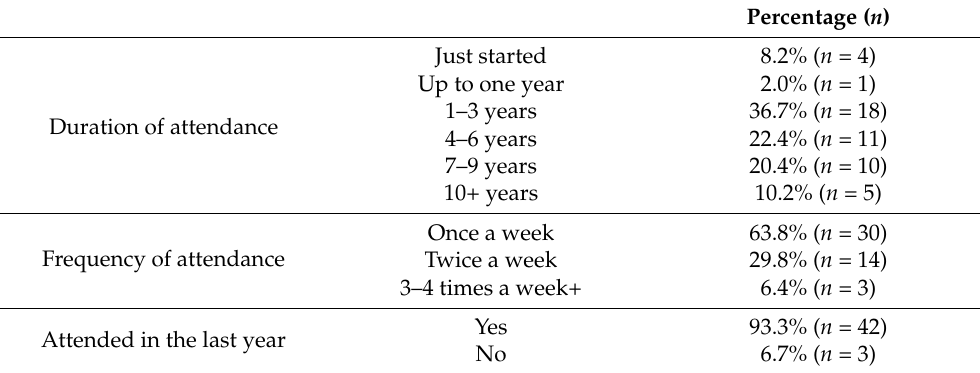
Table 1. Member attendance information at timepoint